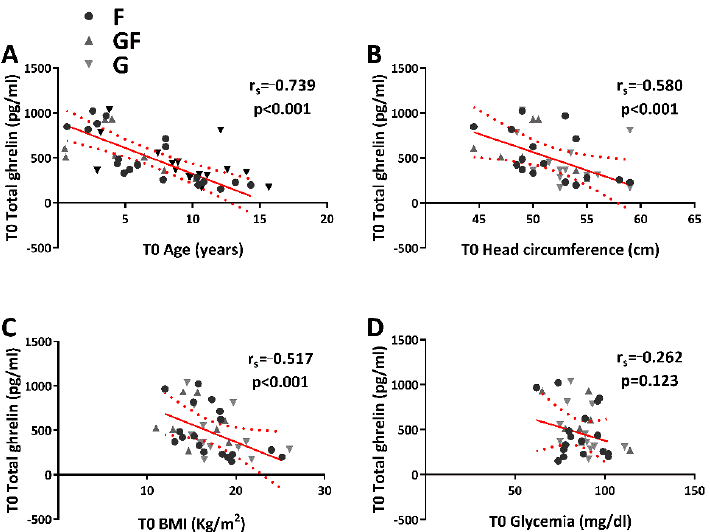
Figure 4. Relationship between total ghrelin plasma levels and age, head circumference, body mass index (BMI), and glycemia ( A – D ). Spearman correlation coefficients are reported. Furthermore, no correlation (r s = − 0.168, p = 0.305) was defined between the ghrelin- to-DAG ratio and age (Figure 5A), but it was instead present between the ghrelin-to- DAG ratio (Figure 5B) and head circumference (r s = − 0.362, p = 0.039). The ghrelin-to- DAG ratio (Figure 5C, D) was not correlated to BMI (r s = − 0.157, p = 0.365) or glycemia (r s = 0.077, p = 0.666).